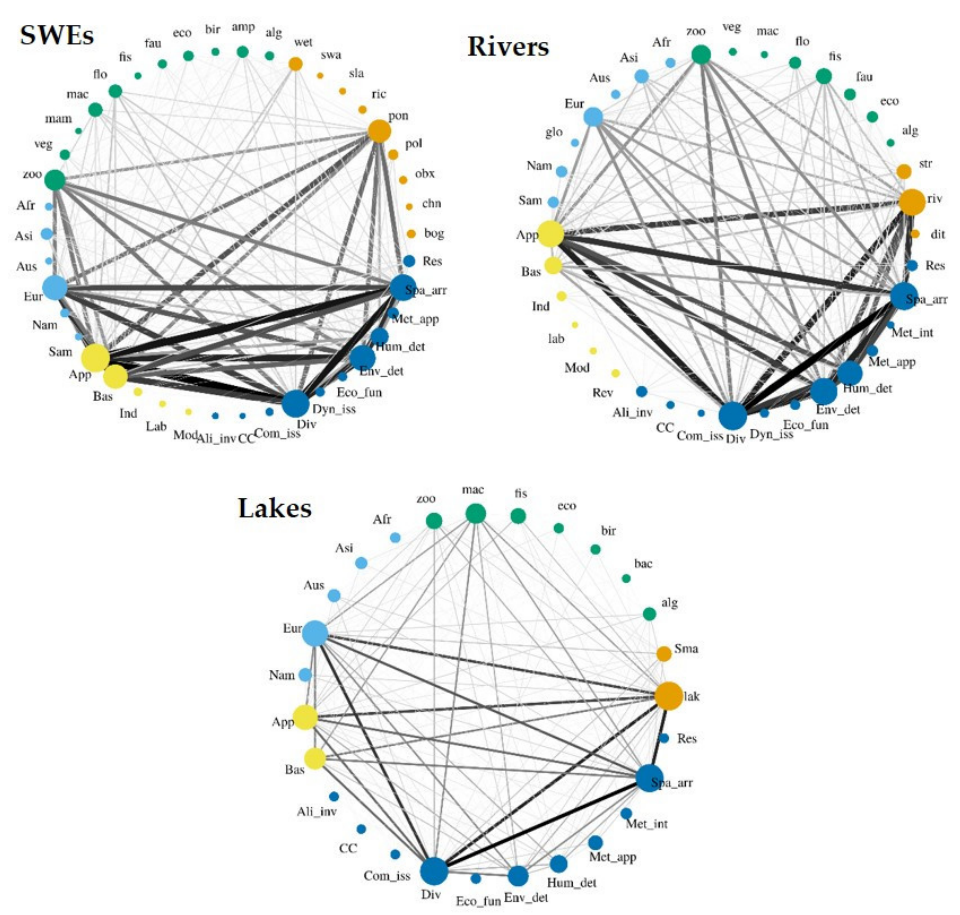
Figure 2. Representativeness and links (as reported in the legend, expressed in number of links; see Table 1) among the descriptive topics evaluated by matrix method (habitat type ( orange ; pon, ric, wet, bog, pol, swa, obx, chn, sla, dit, riv, str, sma, lak); biotic target ( green ; eco, fau, flo, veg, alg, mac, zoo, amp, bir, mam); geographical location of investigated aquatic ecosystems ( light blue ; Eur, Afr, Asi, NAm, SAm, Aus, glo); research type ( yellow ; App, Ind, Bas, Exp, lab, Mod, Rev); and the target issues ( dark blue ; Div, Env_det, Hum_det, CC, Met_app, Met_int, Dyn, Com, Spa_arr, Eco_fun, Ali_inv, Res)) for SWEs, rivers, and lakes; for definitions of the topic categories see Table 1.